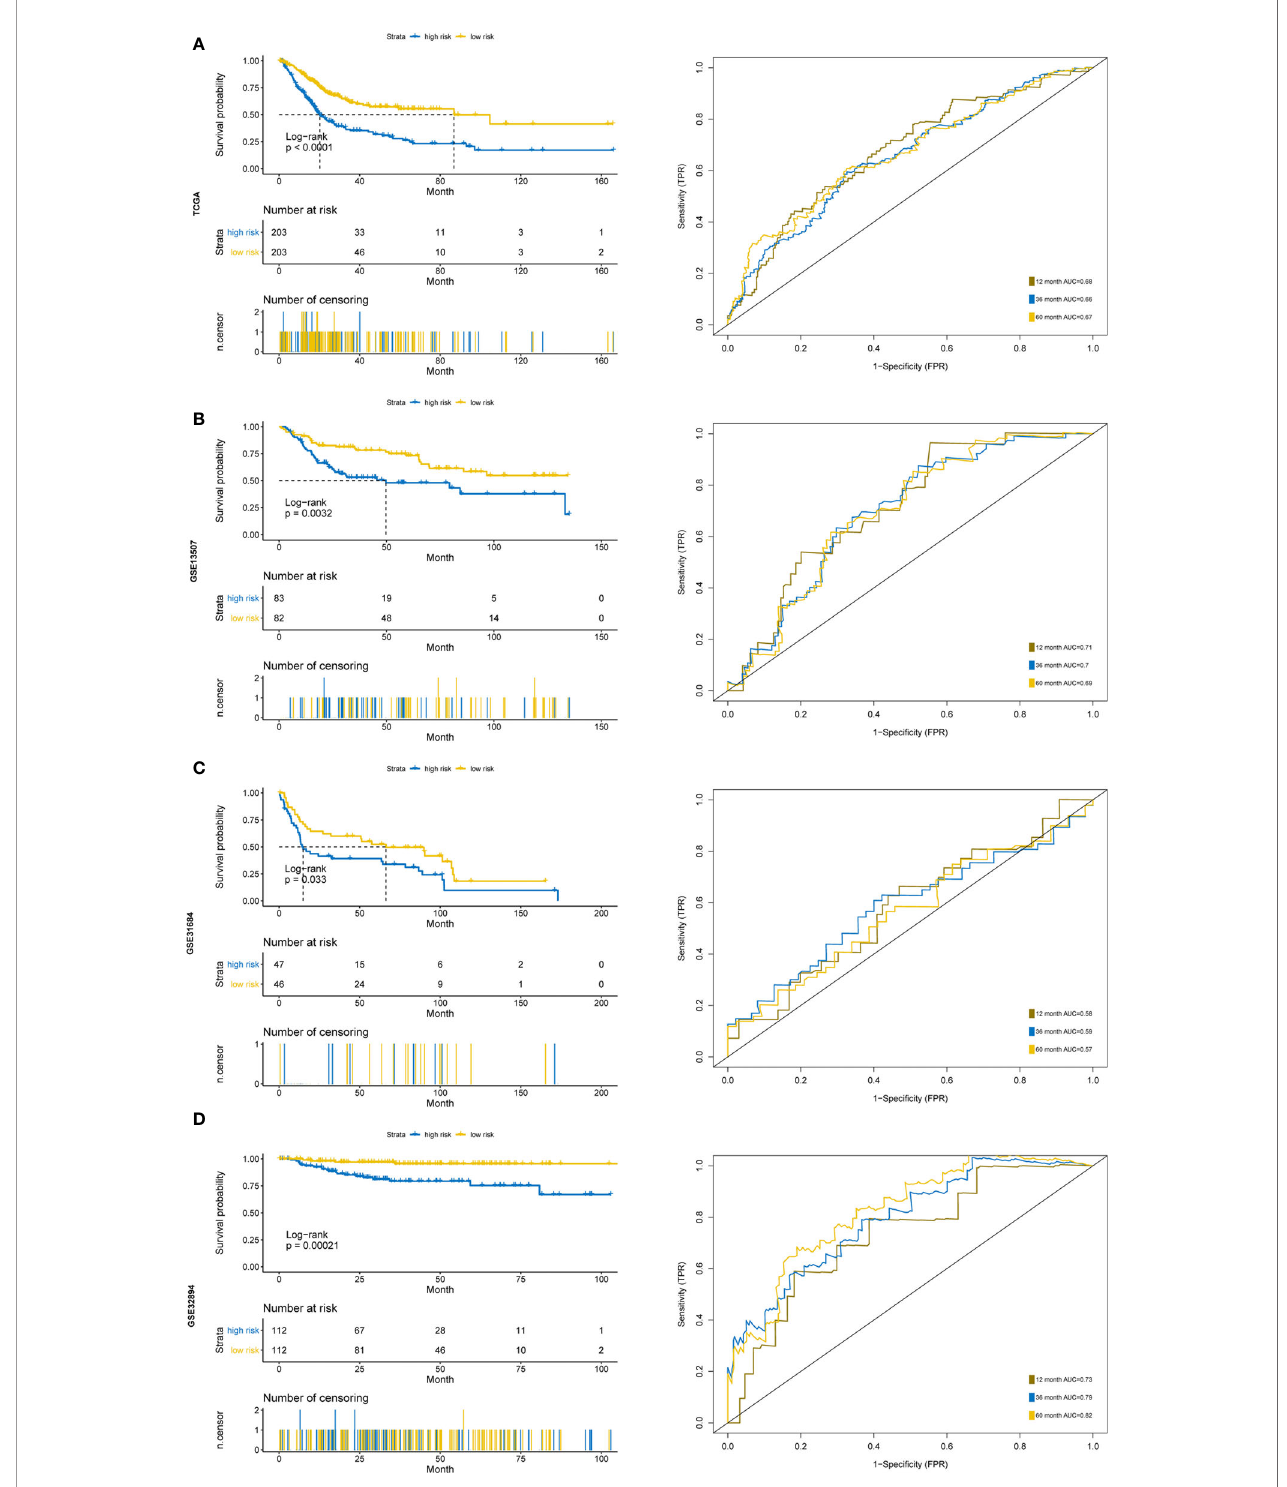
FIGURE 7 | Time-dependent ROC analysis and Kaplan – Meier analysis for the validation of prognostic model in TCGA, GSE13507, GSE31684 and GSE32894. Kaplan – Meier curve and time-dependent ROC analysis of risk score in (A) entire TCGA cohort, (B) GSE13507 cohort, (C) GSE31684 cohort, (D) GSE32894